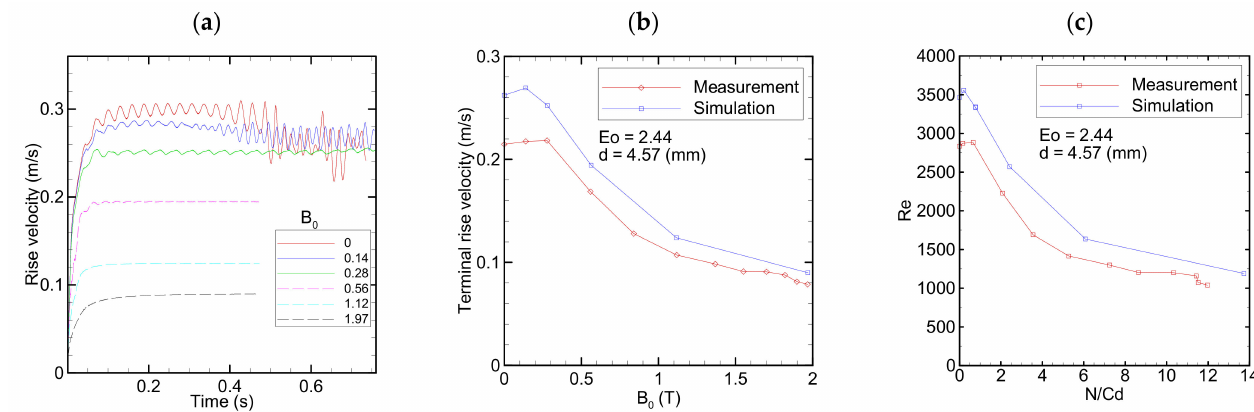
Figure 13. Computed rise velocities for different magnetic field strengths for Eo = 2.44: ( a ) the time history of the rise velocity, ( b ) the time-averaged rise velocity as a function of the magnetic field intensity and ( c ) the bubble Reynolds number as a function of N / C d